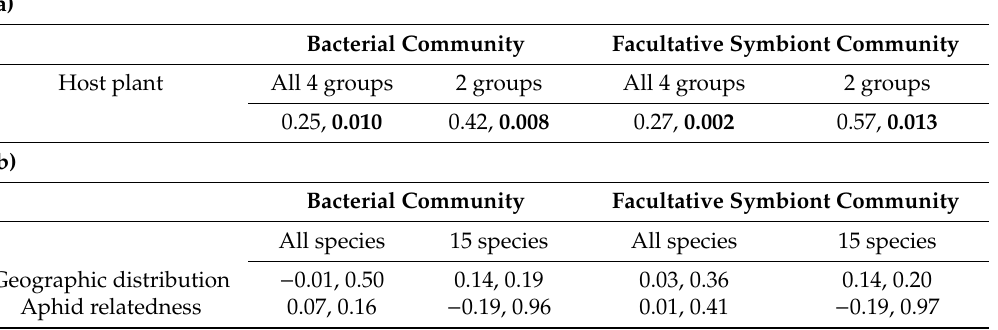
Table 2. Statistical test results for bacterial and facultative symbiont communities in relation to di ff erent